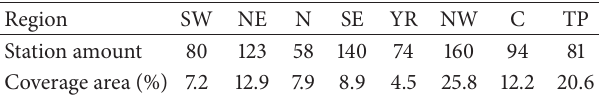
Table 2: Statistical information of eight regions. Region SW NE N